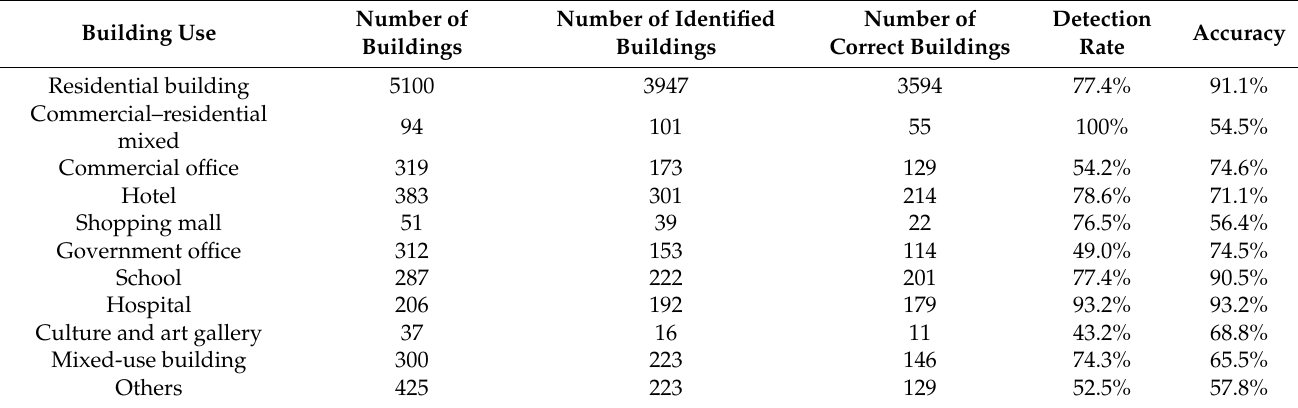
Table 7. The validation results of building use determination.